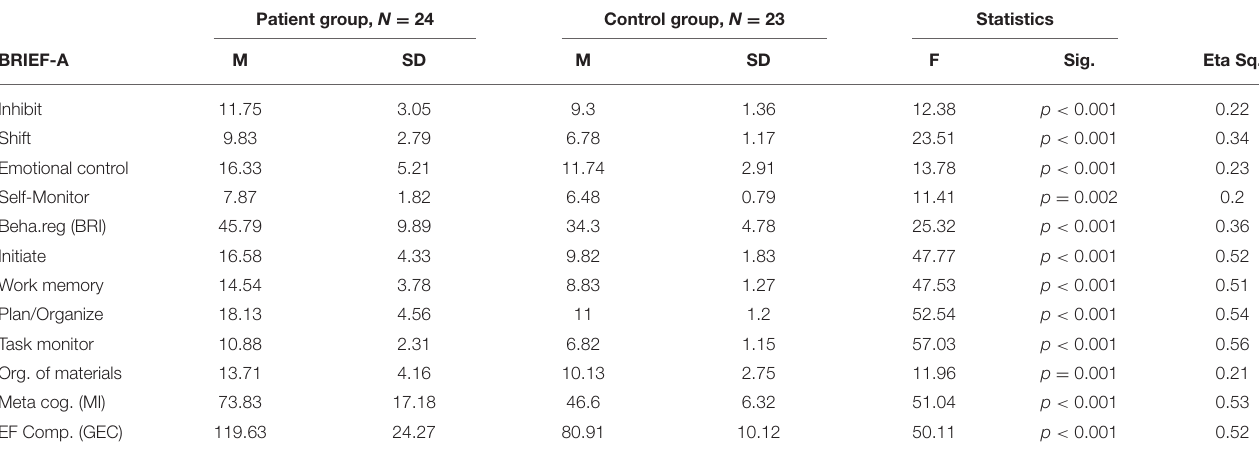
TABLE 3 | BRIEF-A self-report for patient and control